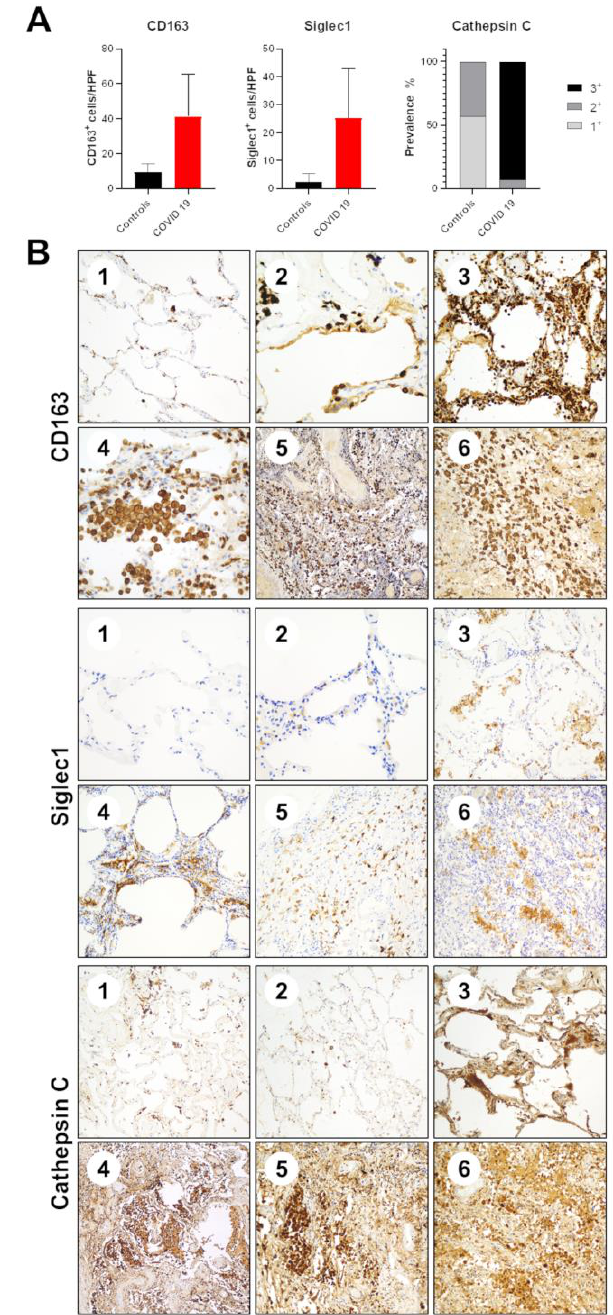
Figure 5. Immunohistochemical validation of gene expression profiling data. ( A ) Boxplots of the expression of CD163, Siglec-1 and Cathepsin C by means of IHC in samples and controls. ( B ) Representative IHC staining of CD163, Siglec-1 and Cathepsin C in control (1 and 2) and COVID-19 derived (3 – 6) samples.